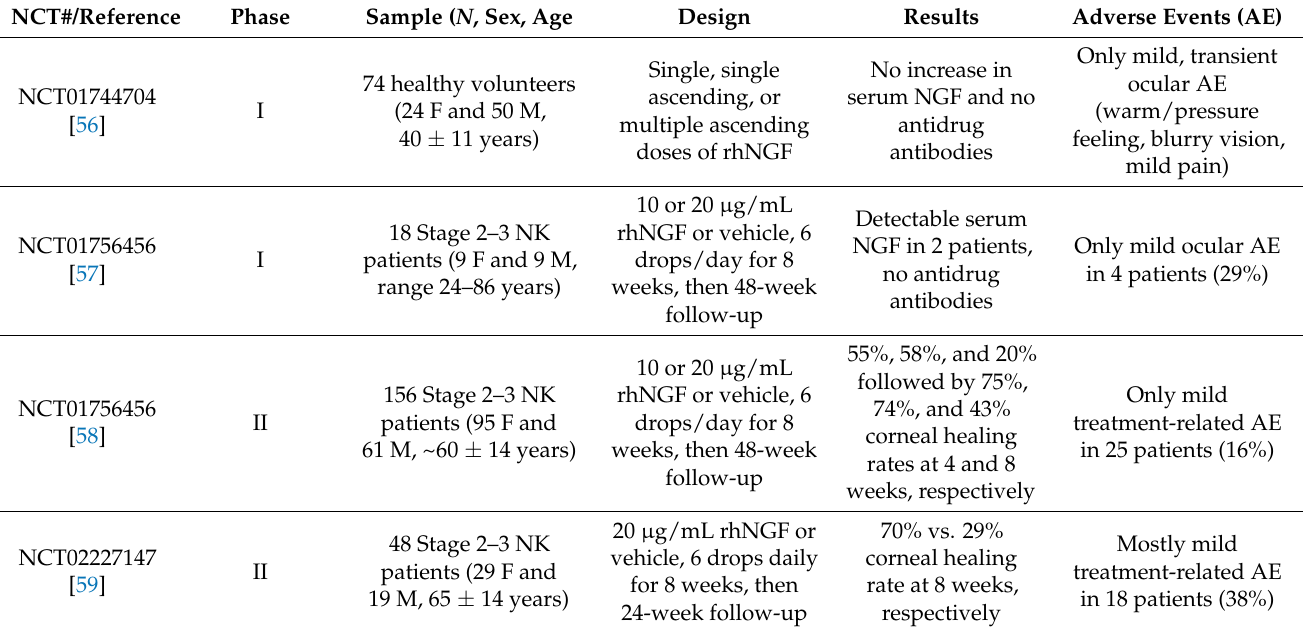
Table 2. Clinical trials leading to FDA-approval of recombinant